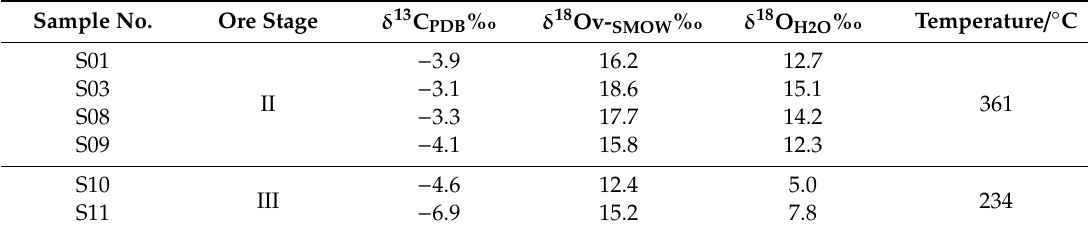
Table 3. Carbon-oxygen isotope compositions of calcite from Xianglushan Fe-Cu deposit. Sample